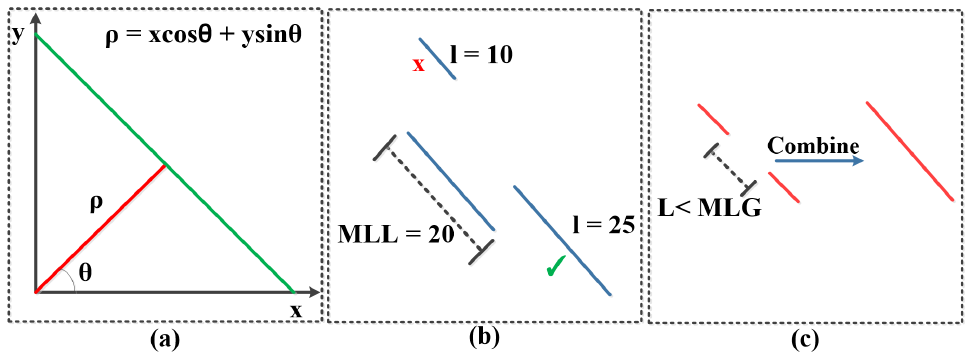
Figure 4. PPHT algorithm parameters illustration. ( a ) ρ and θ of a line in polar coordinates. ( b ) Minimum line length condition to accept or reject lines. ( c ) Maximum line gap (MLG) con- dition to combine two points or line